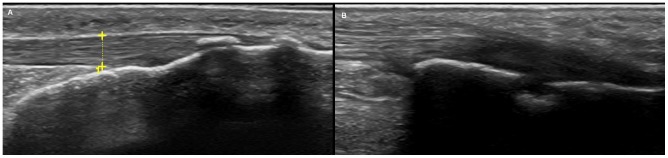
Representative images of features detected with US exploration.A) Example of analysis of the Achilles tendon thickness measured between the two yellow crosses in one patient, and B) Erosion detected in the superior pole of the calcaneous in a different patient.